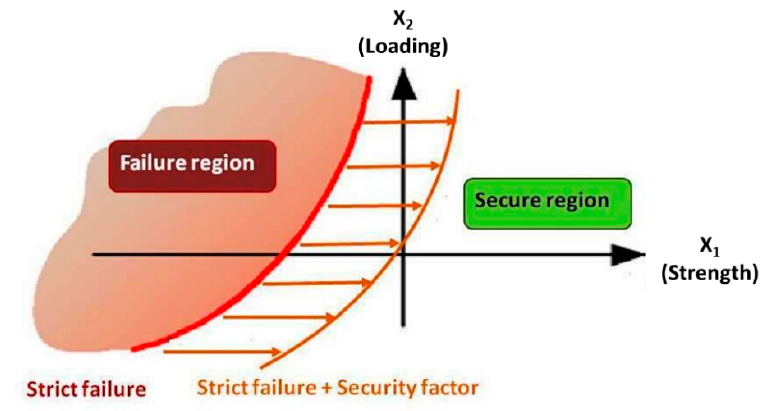
Figure 1. Failure and secure region for a generic bi-dimensional case.